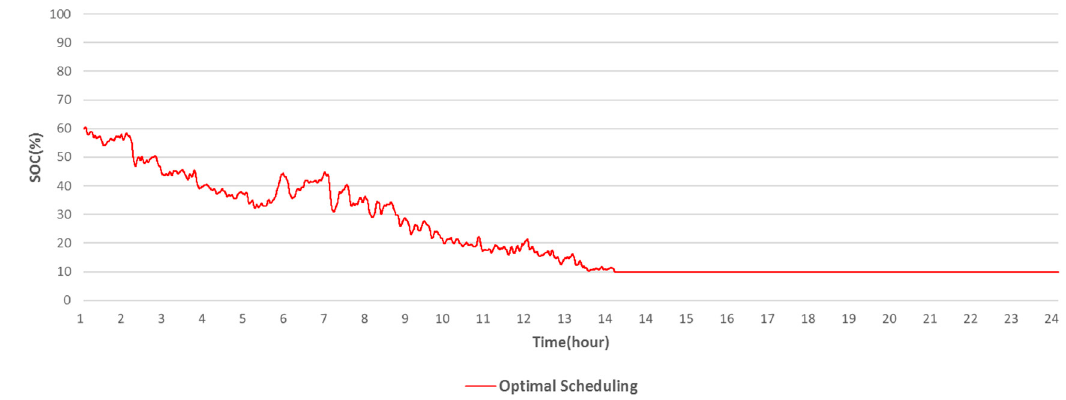
Figure 6. SOC of ESS in real-time operation simulation (Case 2—optimal scheduling algorithm).